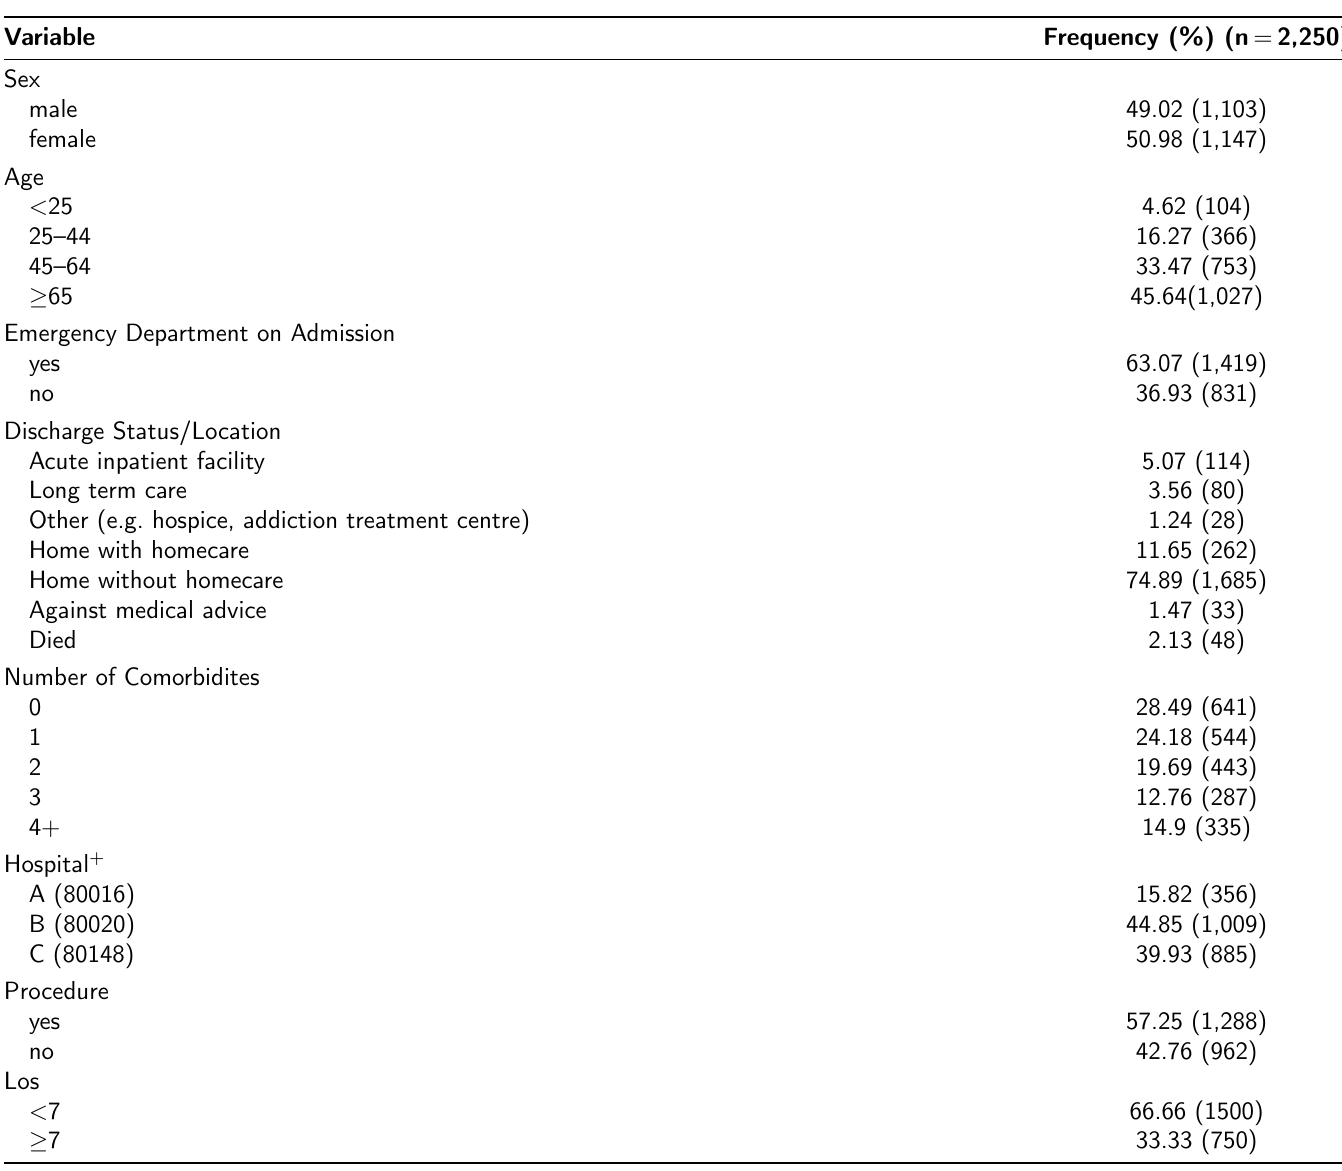
Table 1: Characteristics of 2,250 patient sample